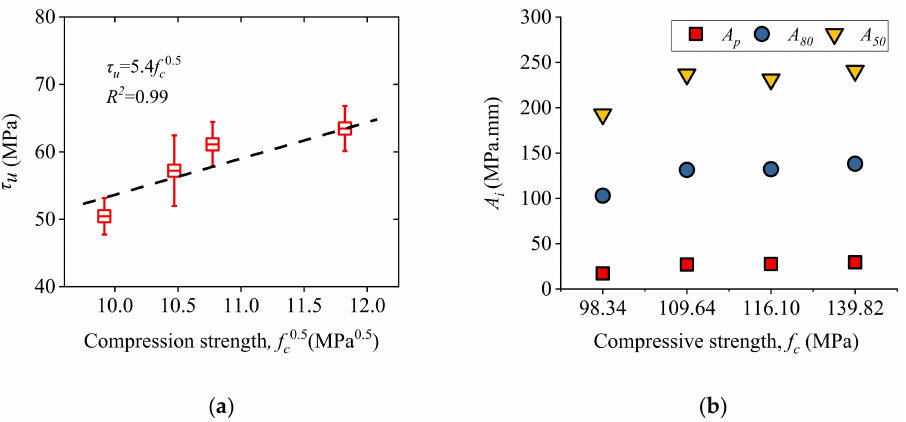
Figure 8. Effect of compressive strength on bond performance: ( a ) bond strength; ( b ) bond